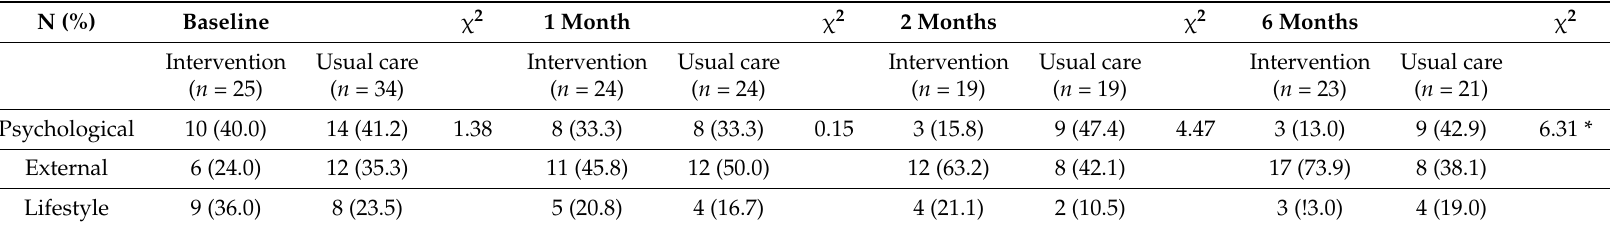
Table 5. Patients’ perceived cause of atrial